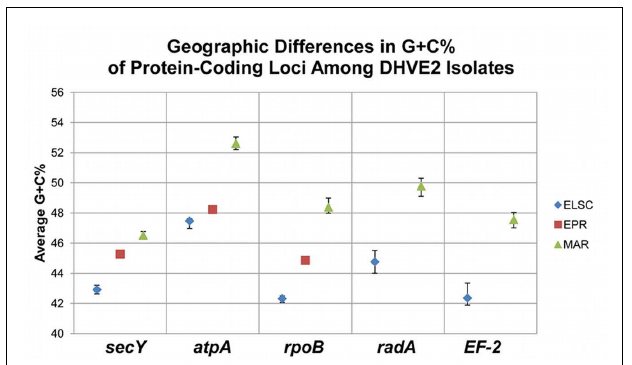
FIGURE 6 | Regional G + C% differences among protein-coding loci from DHVE2 isolates. Average shown, bars indicate range of observed